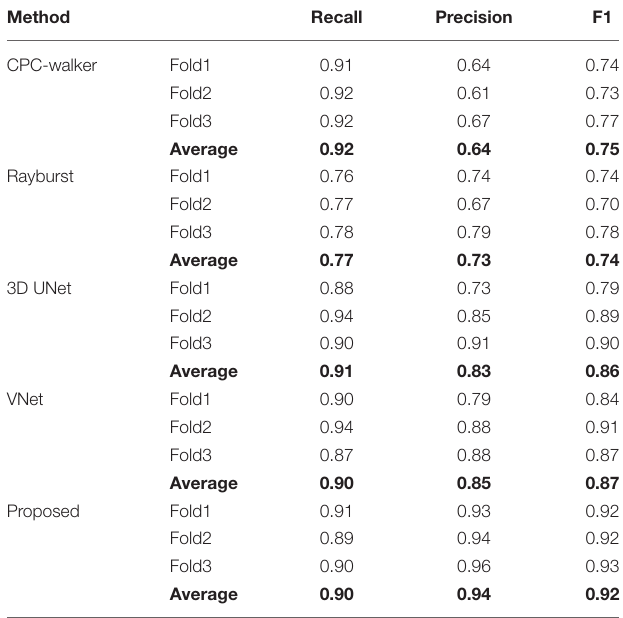
TABLE 1 | Comparison of performance of neuronal soma localization results using different methods. Method